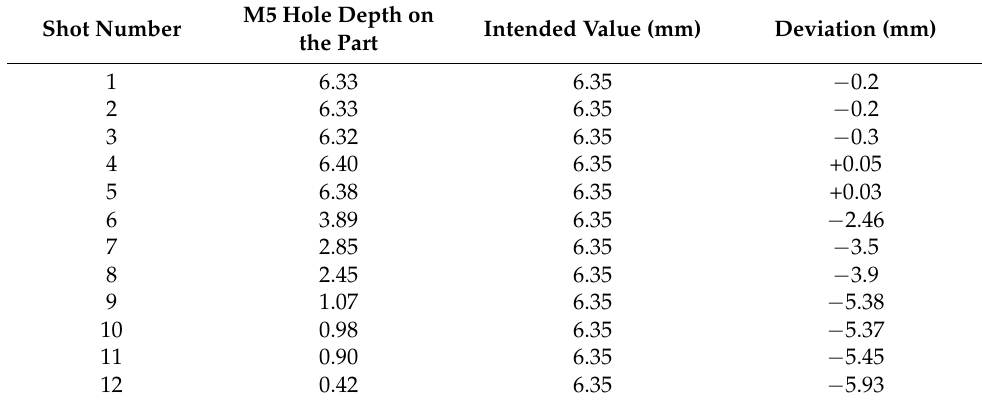
Figure 29. ( a ) 12th moulded part showing defects ( b ) State of core pins (broken) on the 3DIM after 12 shots. The moulded parts have no cored holes as the core pins on the tool are completely broken. Table 8. Hole depth of the M5 core pin on each of the moulded part. Red text indicates damage to the